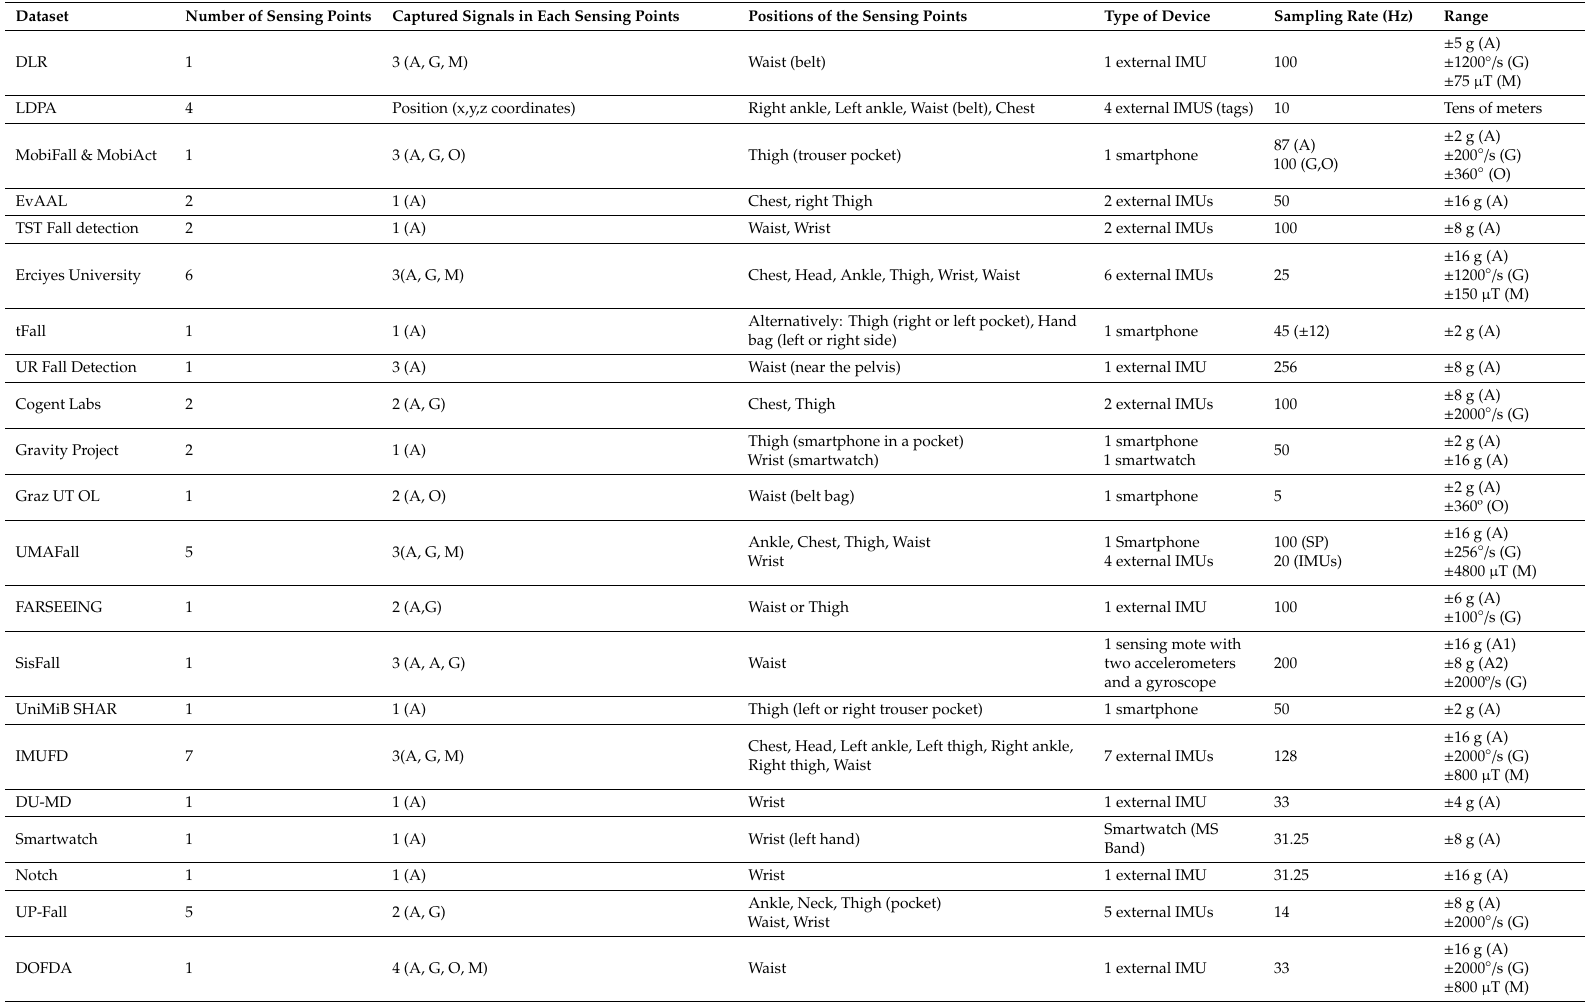
Table 3. Position and characteristics of the sensor used in the di ff erent datasets. Note: A: Accelerometer, G: Gyroscope, O: Orientation measurements, M: Magnetometer. SP: